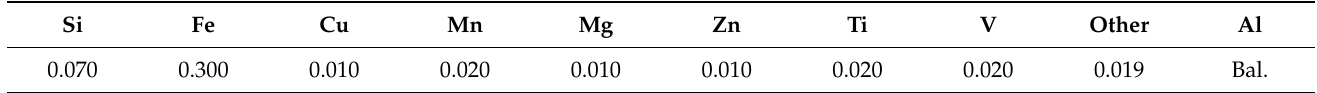
Table 1. AA1050 chemical composition